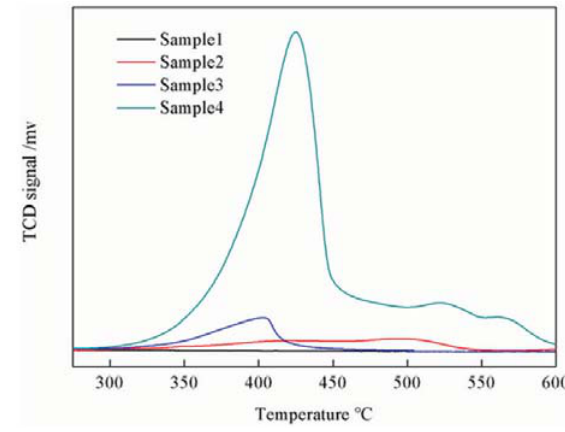
Figure 13: NH -TPD diagram for the different samples. Figure 14: NO-TPD diagram for the different 3